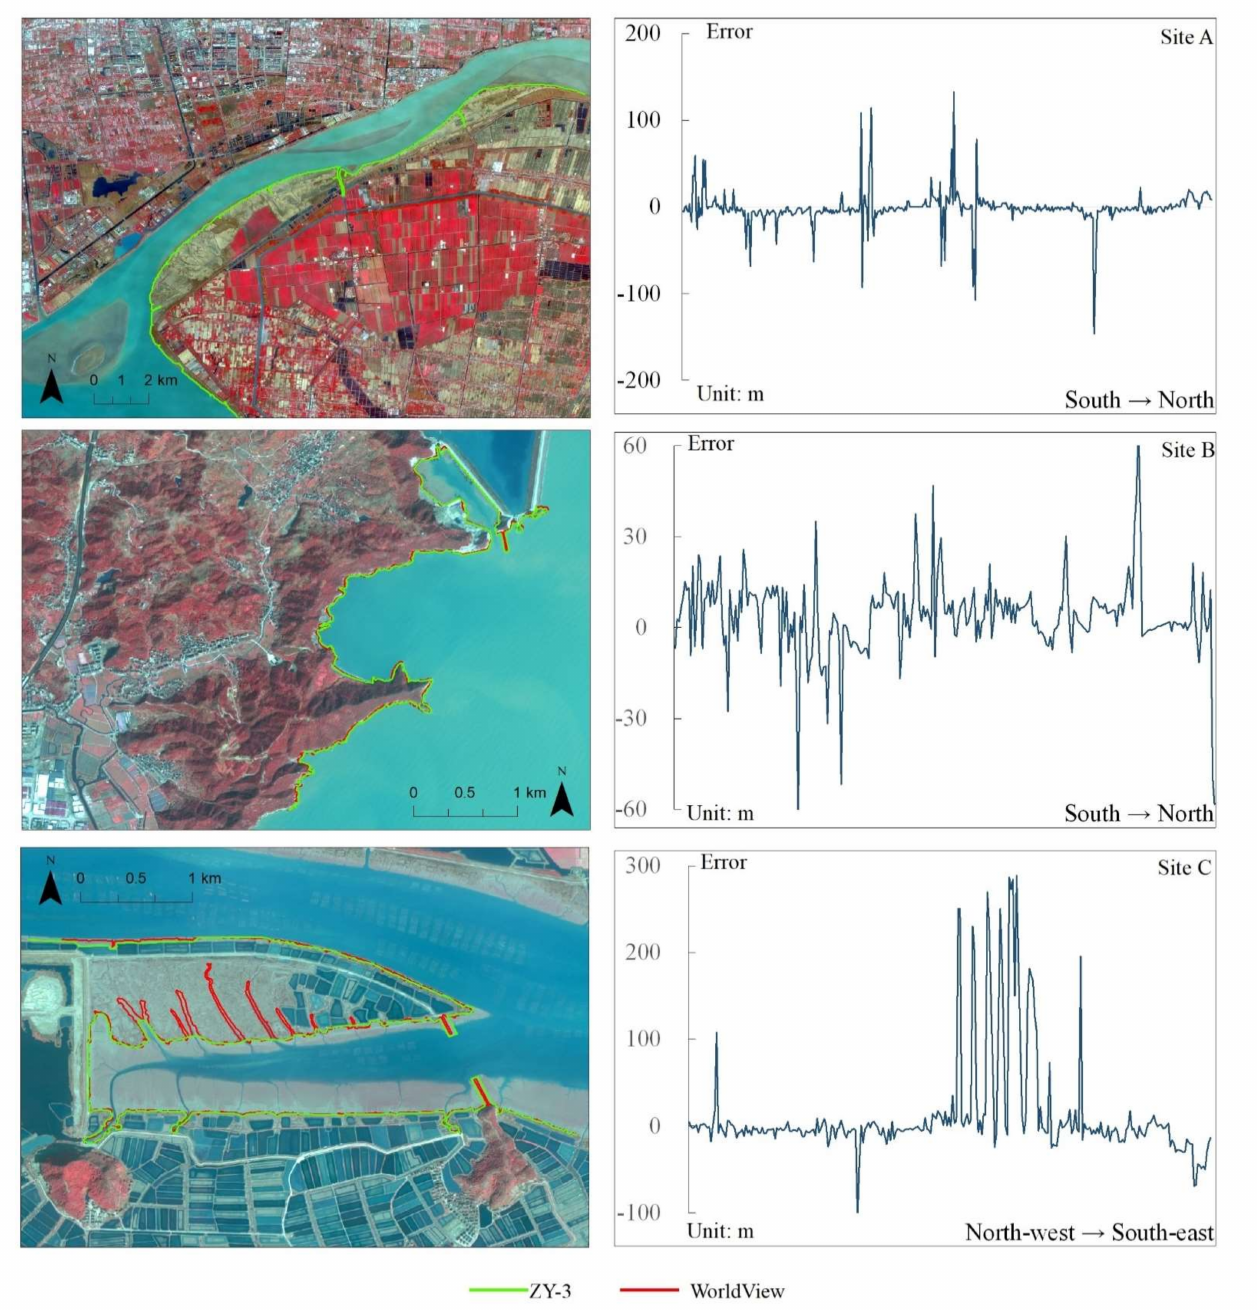
Figure 6. The extracted coastlines of GF-1/ZY-3 and ground truth of WorldView ( left ) and the deviation distribution charts ( right